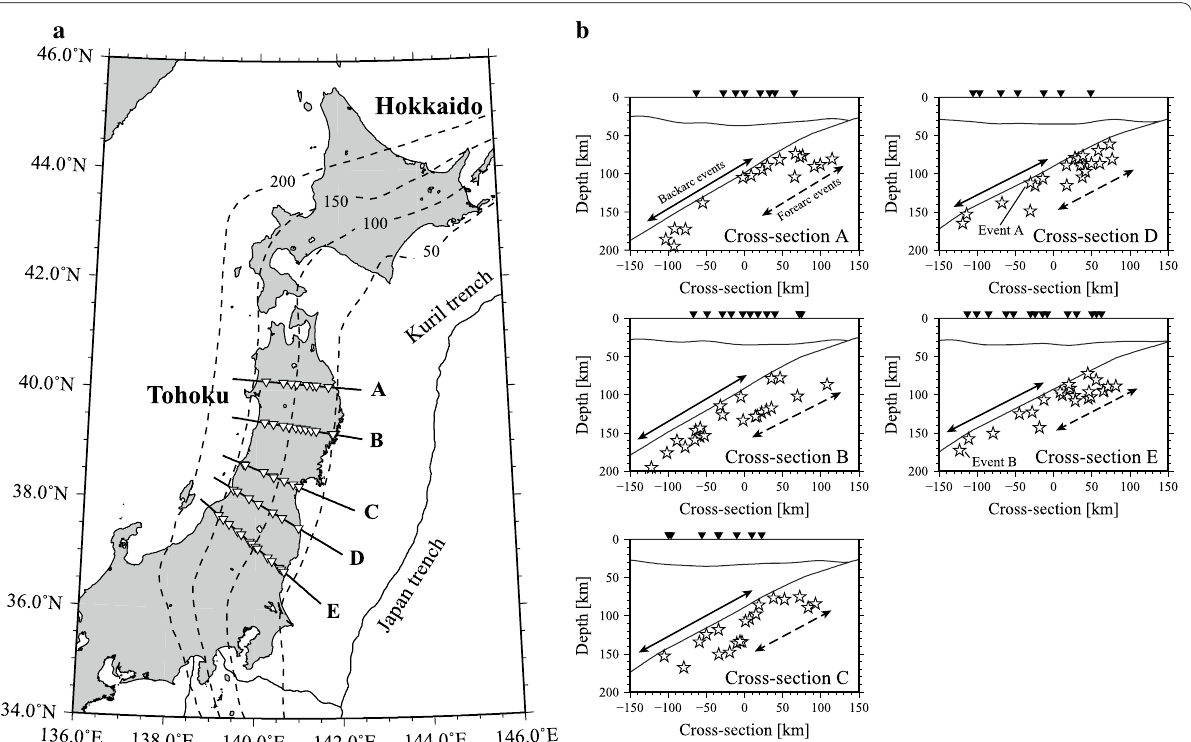
Fig. 1 a Map of NE Japan showing locations of the cross-sections and b distributions of the earthquakes (stars) and stations (inverted triangles) analyzed in this study. a The stations used are denoted as white inverted triangles. The dashed black lines indicate the depth contours of the upper surface of the subducting Pacific slab (Nakajima et al. 2009). The contour interval is 50